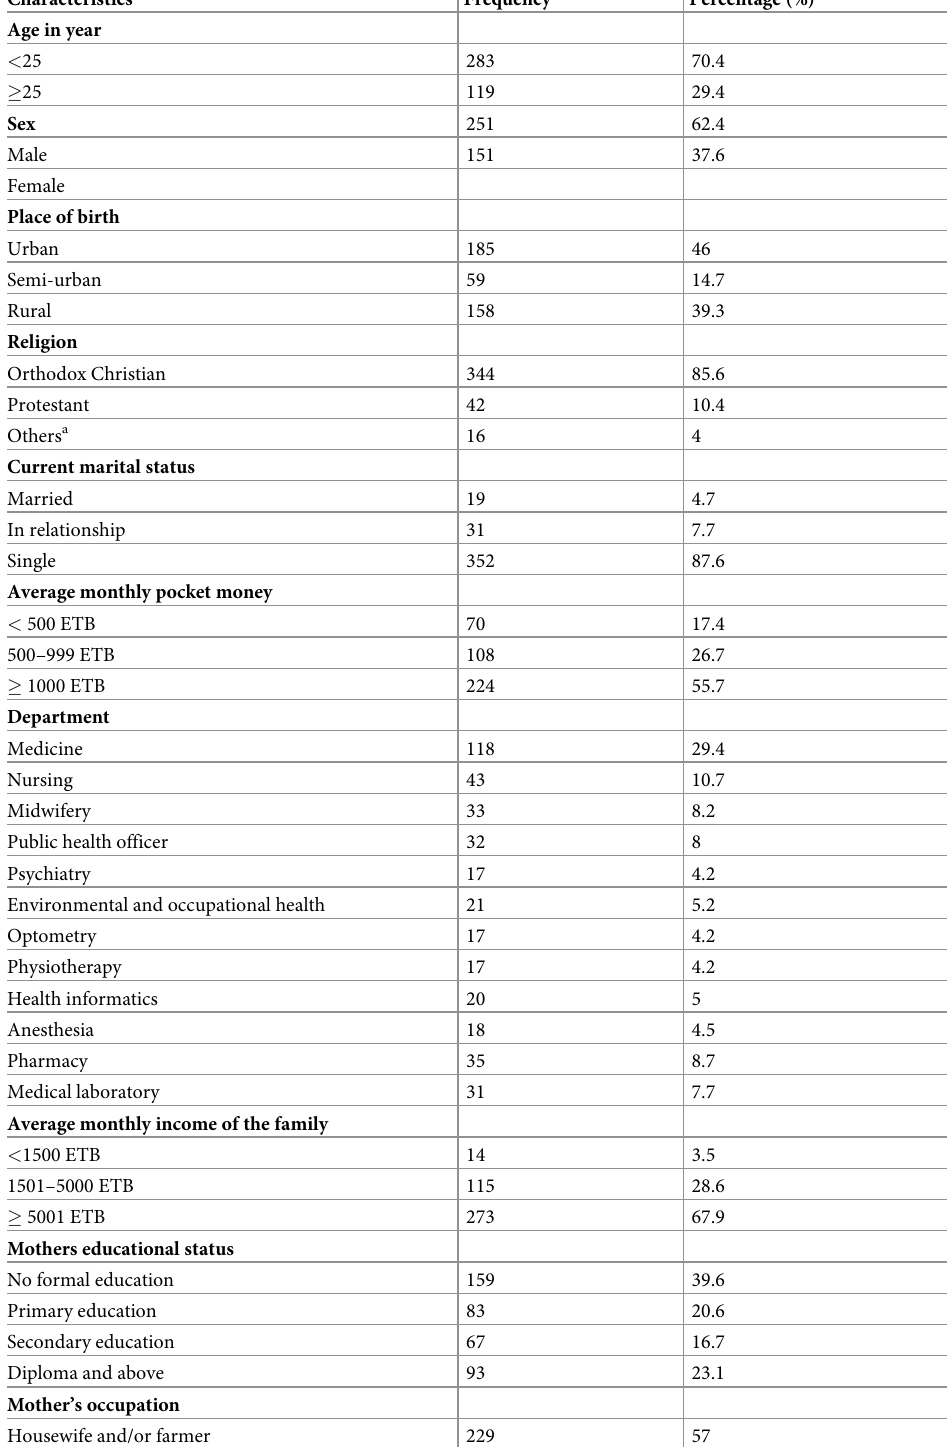
Table 1. Socio-demographic characteristics of study participants in the University of Gondar, college of medicine and health sciences, northwest Ethiopia, 2021 (n = 402).